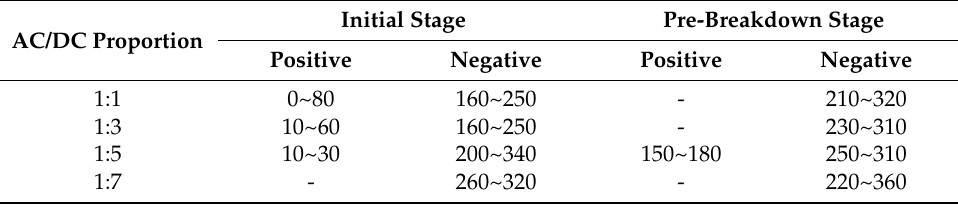
Table 6. Relationship between PD phase distribution AND AC/DC proportions ( φ / ◦